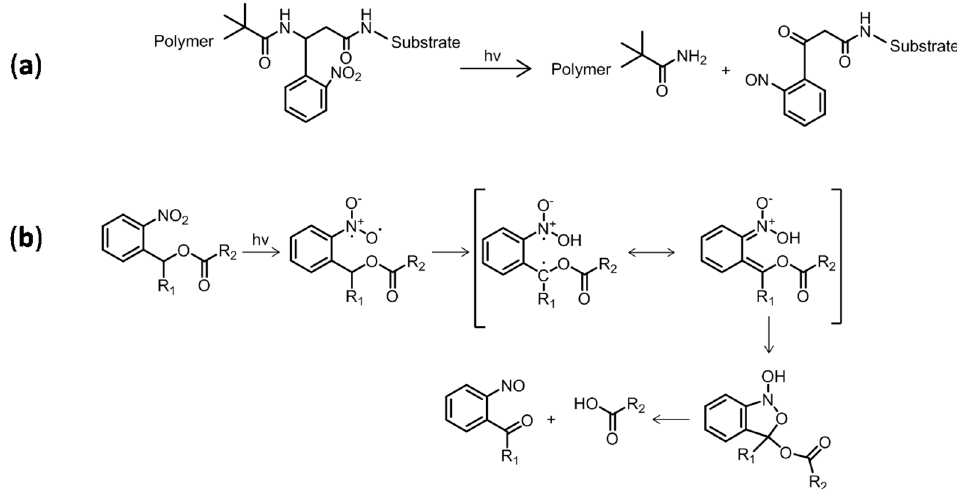
Figure 1. ( a ) Photocleavage of grafted polymer chains by photocleaving substrate o − nitrobenzene